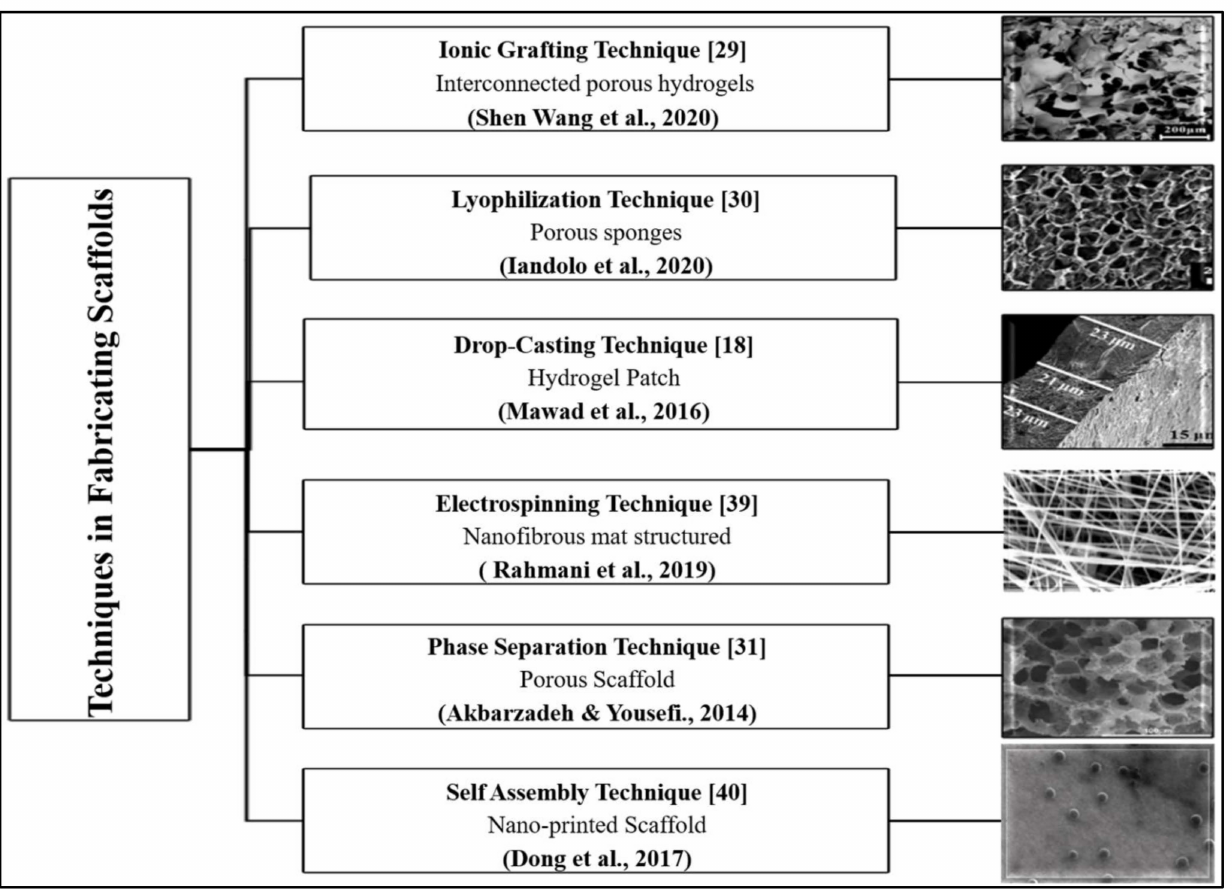
Figure 3. Techniques in fabricating scaffolds and their respective scanning electron microscope images